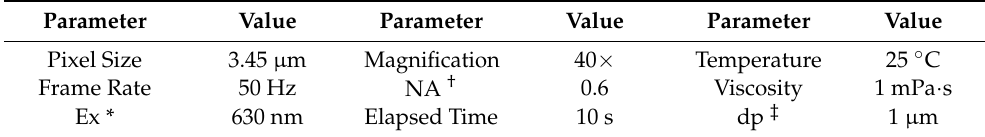
Table 1. Default parameters for the simulated particle images. Parameter Value Parameter Value Parameter Value Pixel Size 3.45 µ m Magnification 40 × Temperature 25 ◦ C Frame Rate 50 Hz NA † 0.6 Viscosity 1 mPa · s Ex * 630 nm Elapsed Time 10 s dp